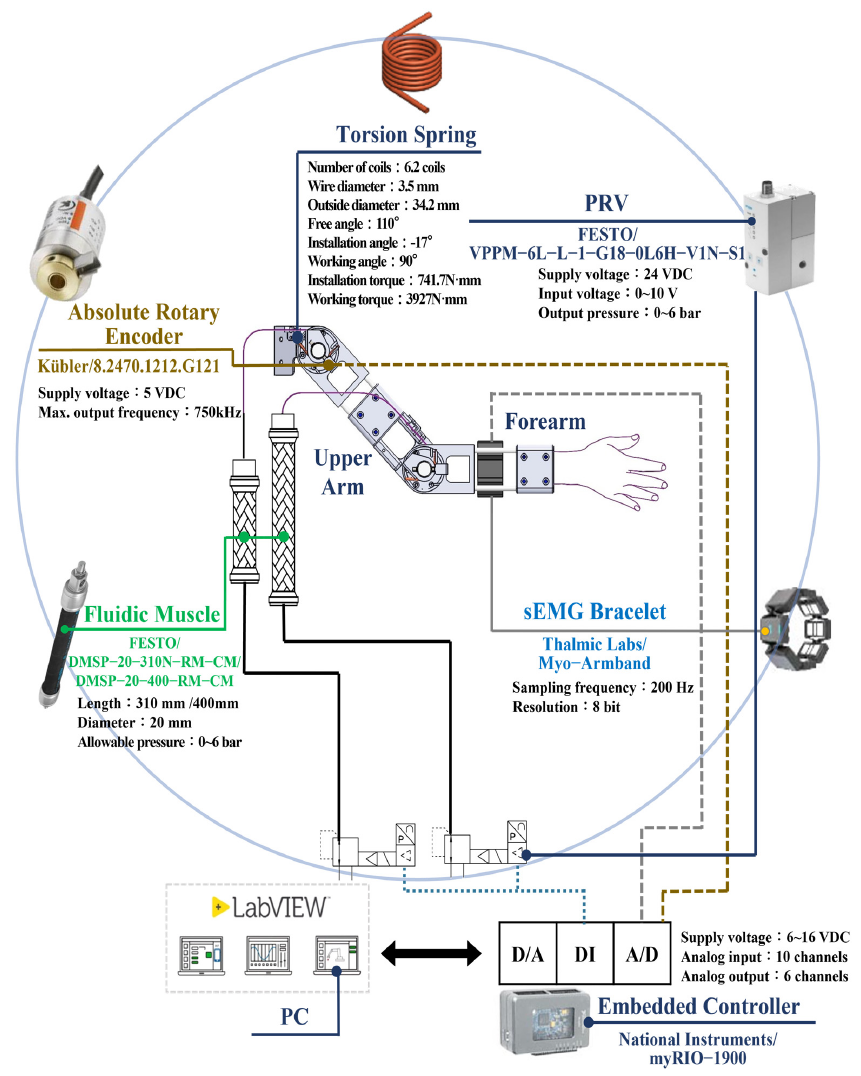
Figure 3. Joint structure diagram of the torsion spring module.